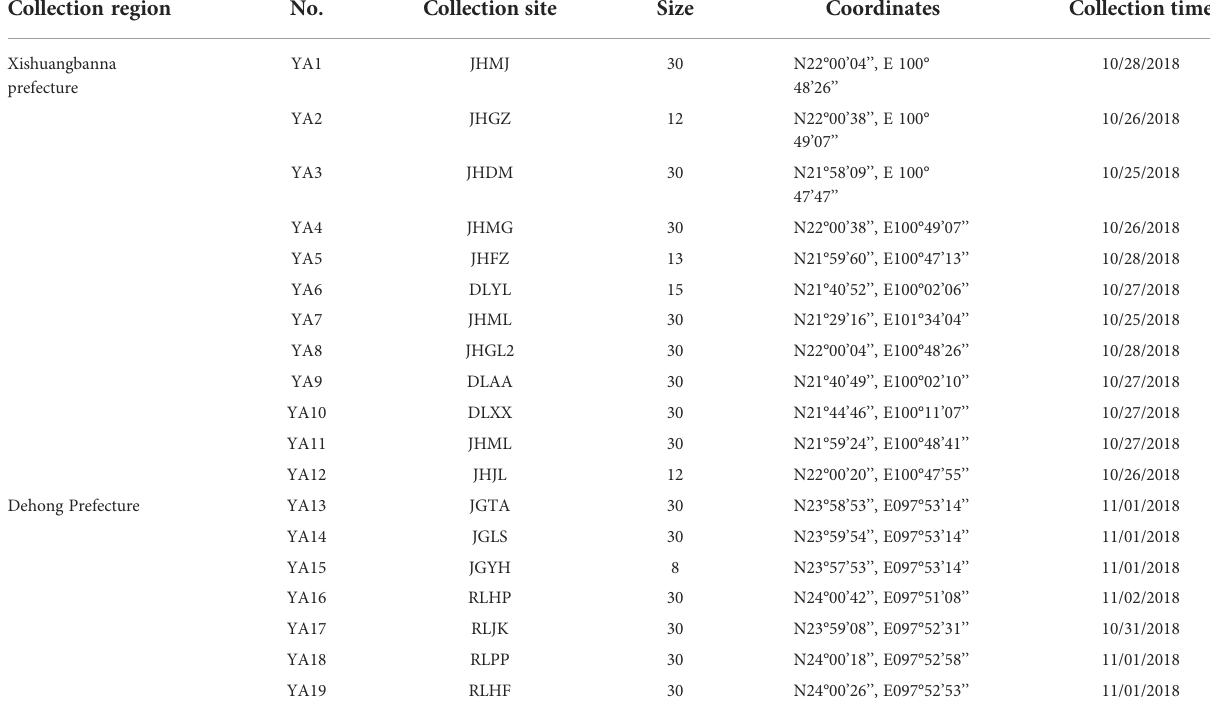
TABLE 2 Collection information of Ae. aegypti in Yunnan Province in 2018. Collection